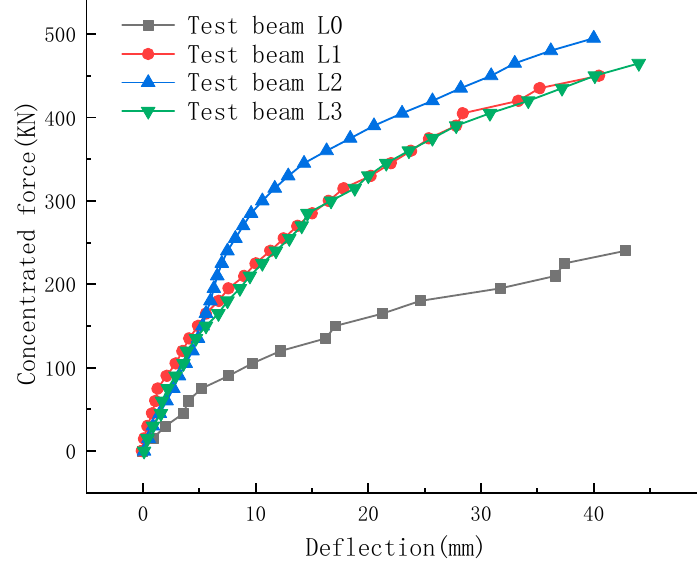
Figure 12. Load–deflection curve (crack development yield limit).